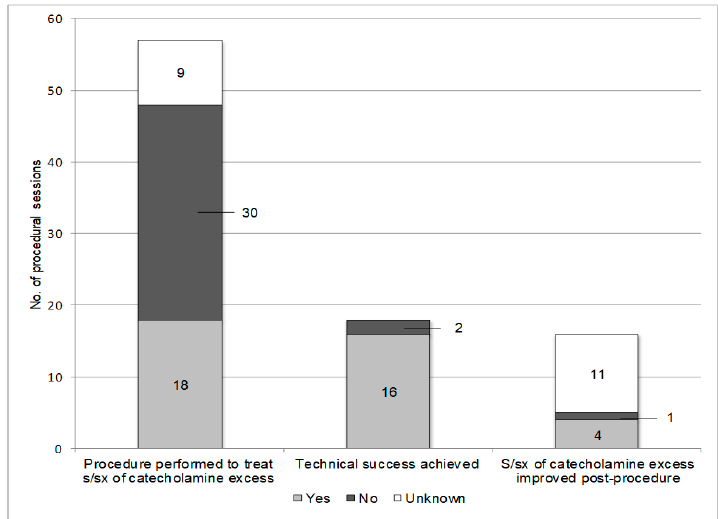
Figure 1. Outcomes of ablations performed to treat manifestations of catecholamine excess in patients with metastatic pheochromocytoma and paraganglioma. Eighteen procedures were performed to treat patients with manifestations of catecholamine excess. Technical success was achieved in 16 of those procedures, after which five patients had known symptom outcomes. Of those five, four patients had improvement in symptoms of catecholamine excess following ablation. Abbreviations: s/sx, signs and symptoms. Cancers 2019 , 11 , x